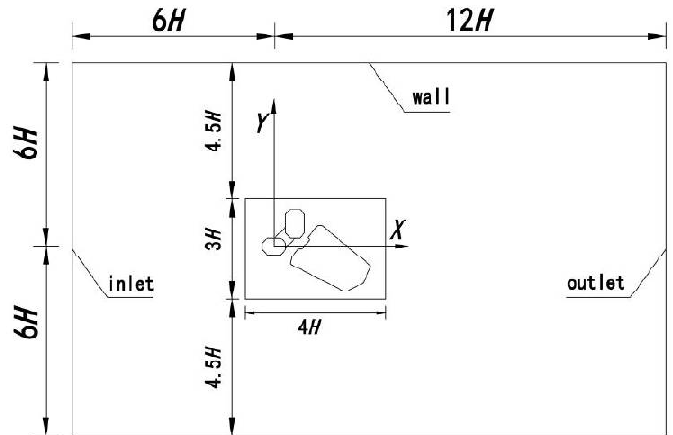
Figure 2. Computational domain meshing partitioning.